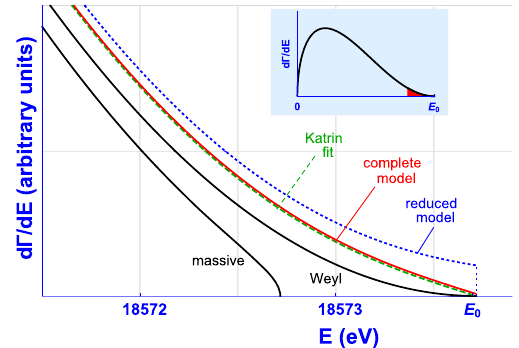
Fig. 1 Theoretical electron energy spectrum (differential decay rate) near the endpoint in tritium decay at rest; E 0 = 18573 . 7 eV is the endpoint energy fitted by KATRIN. The curves demonstrate the cases for: massive neutrino with m ν = 1 eV (the kinematical limit in the decay with a massive neutrino is E 0 − m ν ); massless (Weyl) neutrino; massiveneutrinowithinvertedsignof m 2 ν illustratingtheoutcomeofthe KATRIN fit to their data (dashed line); complete model (solid line) and the reduced model (dotted line) for a tachyonic neutrino with κ = 1 eV. ThecurvesforthecompletemodelandtheKATRINfitoverlapinreality buthavebeeninfinitesimallyshiftedforthepurposeofillustration.Inset: figurative visualization of the range covered on the main plot w.r.t. the full electron energy spectrum within bounds [0 , E 0